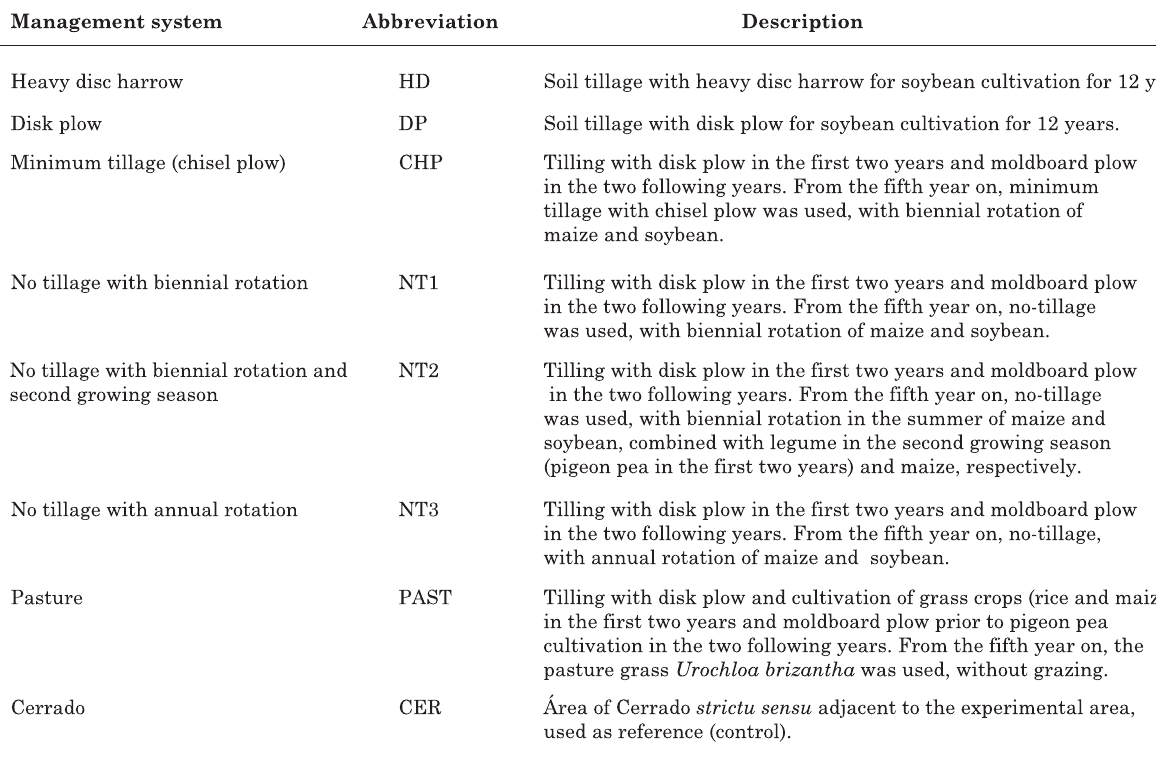
Table 2. Description of the soil management